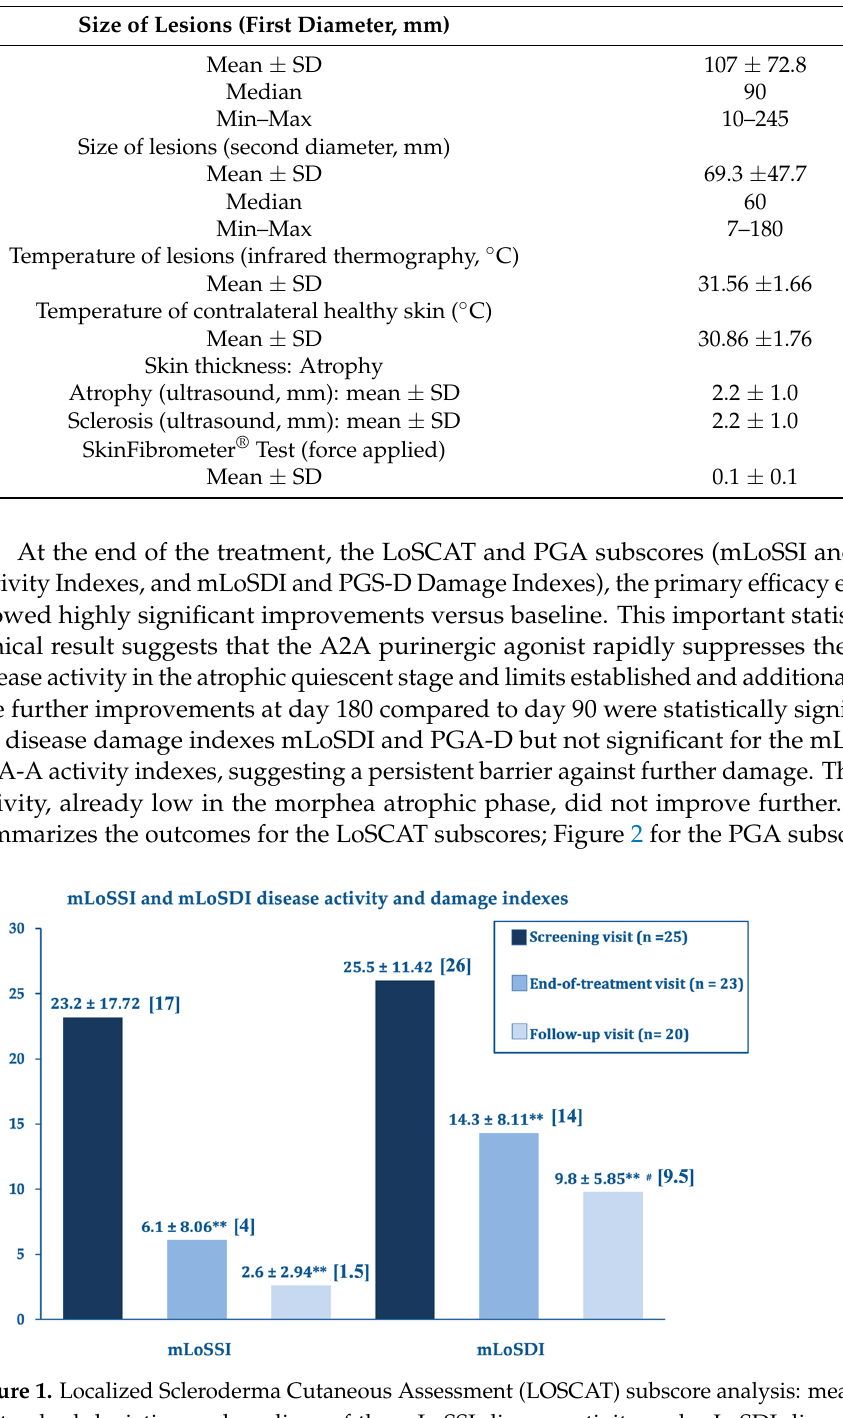
Figure 2. Physician Global Assessment (PGA) subscore analysis: PGA ‐ A and PGA ‐ D mean changes (disease activity and damage, respectively) ± standard deviation and medians, end ‐ of ‐ treatment visit (day 90) and follow ‐ up visit (day 180) vs. screening visit (baseline). ** p < 0.0001 vs. baseline screening visit, # p = 0.023 vs. day 90. Other secondary efficacy endpoints also showed significant improvements in the dimension and estimated mean area of the quiescent morphea lesion (Figure 3) and the histologically assessed atrophy and sclerosis (atrophy: mean total score from 6.7 ± 2.7 at day 0 to 4.1 ± 2.3 after three months with a statistically significant mean decrease of –2.5 ± 1.92; 95% confidence interval –3.35 to –1.65; (sclerosis: mean total score from 3.9 ± 1.4 at day 0 to 2.7 ± 1.3 after three months with a statistically significant mean decrease of –1.18 ± 0.96; 95% confidence interval –1.61 to –0.76). Benefits appeared especially marked for atrophy and sclerosis in the dermis and hypodermis.